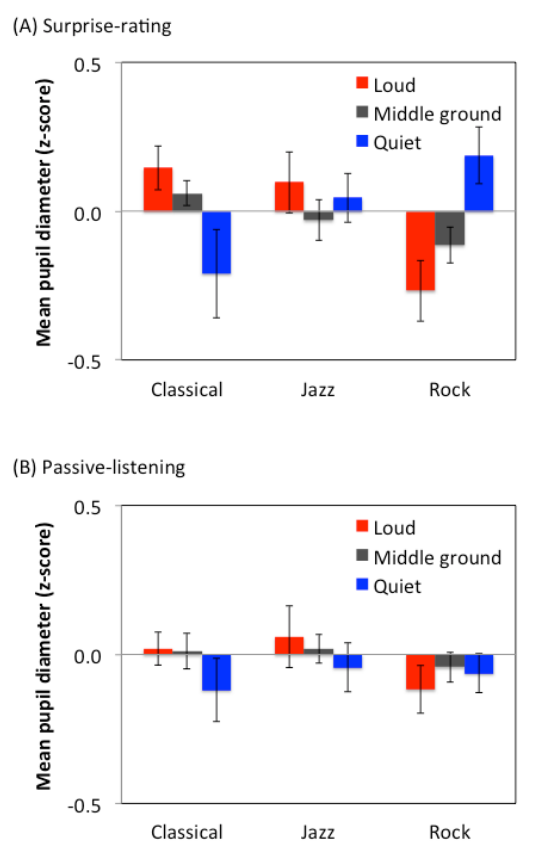
Fig. 8. Mean of the pupil diameter during loud, middle ground, and quiet moments parameterized by music type in surprise-rating (A) and passive-listening (B) sessions. Error bars represent standard errors across